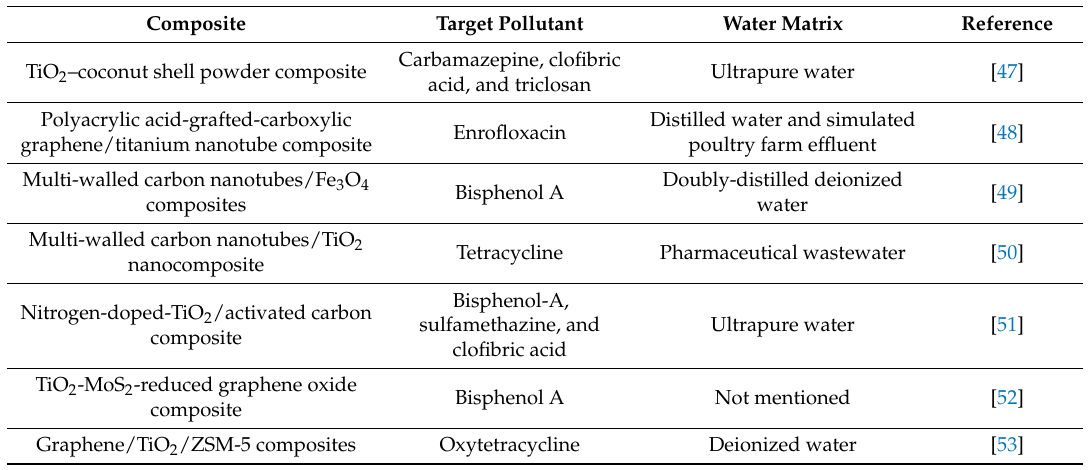
Table 2. Composite materials synthesized for removing organic